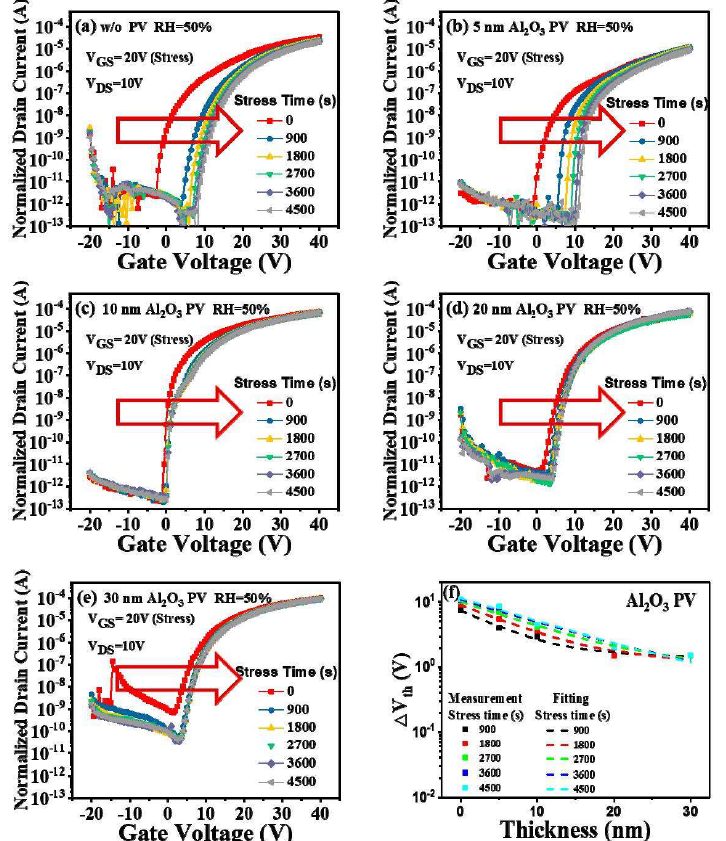
Figure 5. Stress-time dependence of the transfer characteristics of the a-IGZO TFTs with an Al 2 O 3 PV layer thickness of ( a ) 0 nm, ( b ) 5 nm, ( c ) 10 nm, ( d ) 20 nm, and ( e ) 30 nm, respectively; ( f ) experimental data and fitting curves of the Δ V th under PGBS as a function of the PV layer thickness of the a-IGZO TFTs. Table 1. Fitting parameters of the PV layers used for a-IGZO